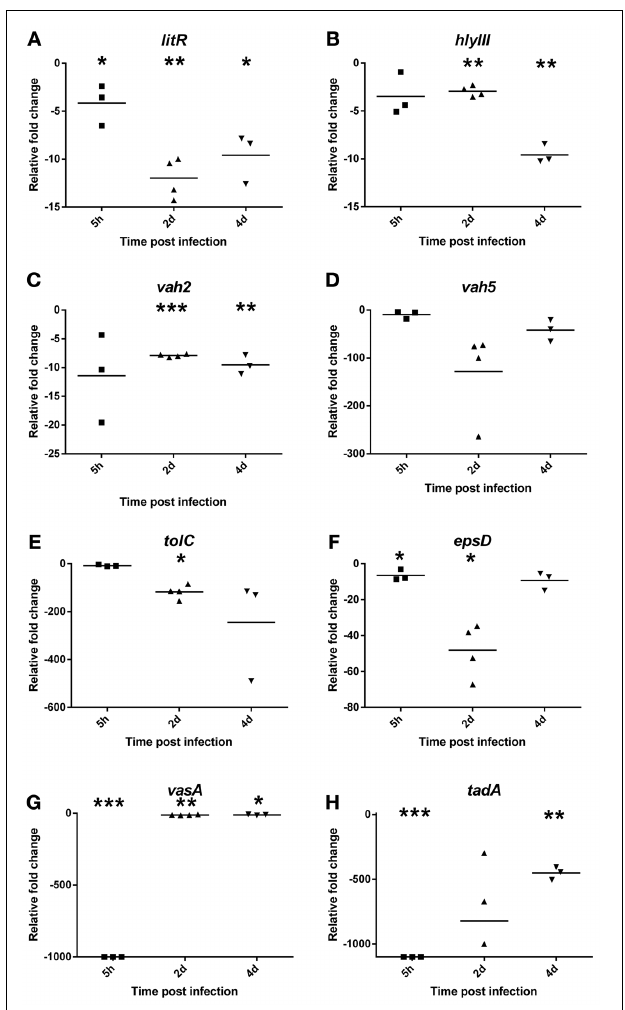
FIGURE 2 | Relative fold change values of potential bacterial virulence genes (A) litR , (B) vah2 , (C) vah5 , (D) hlyIII , (E) tolC , (F) epsD , (G) vasA , and (H) tadA in blood during an experimental V. salmonicida i.p.-infection. Each time point represents the relative expression level of bacterial genes in individual fish and is reported as fold change compared to the average expression levels in bacterial culture (in triplicate) just before challenge. ∗ p < 0 . 05, ∗∗ p < 0 . 005, ∗∗∗ p < 0 .